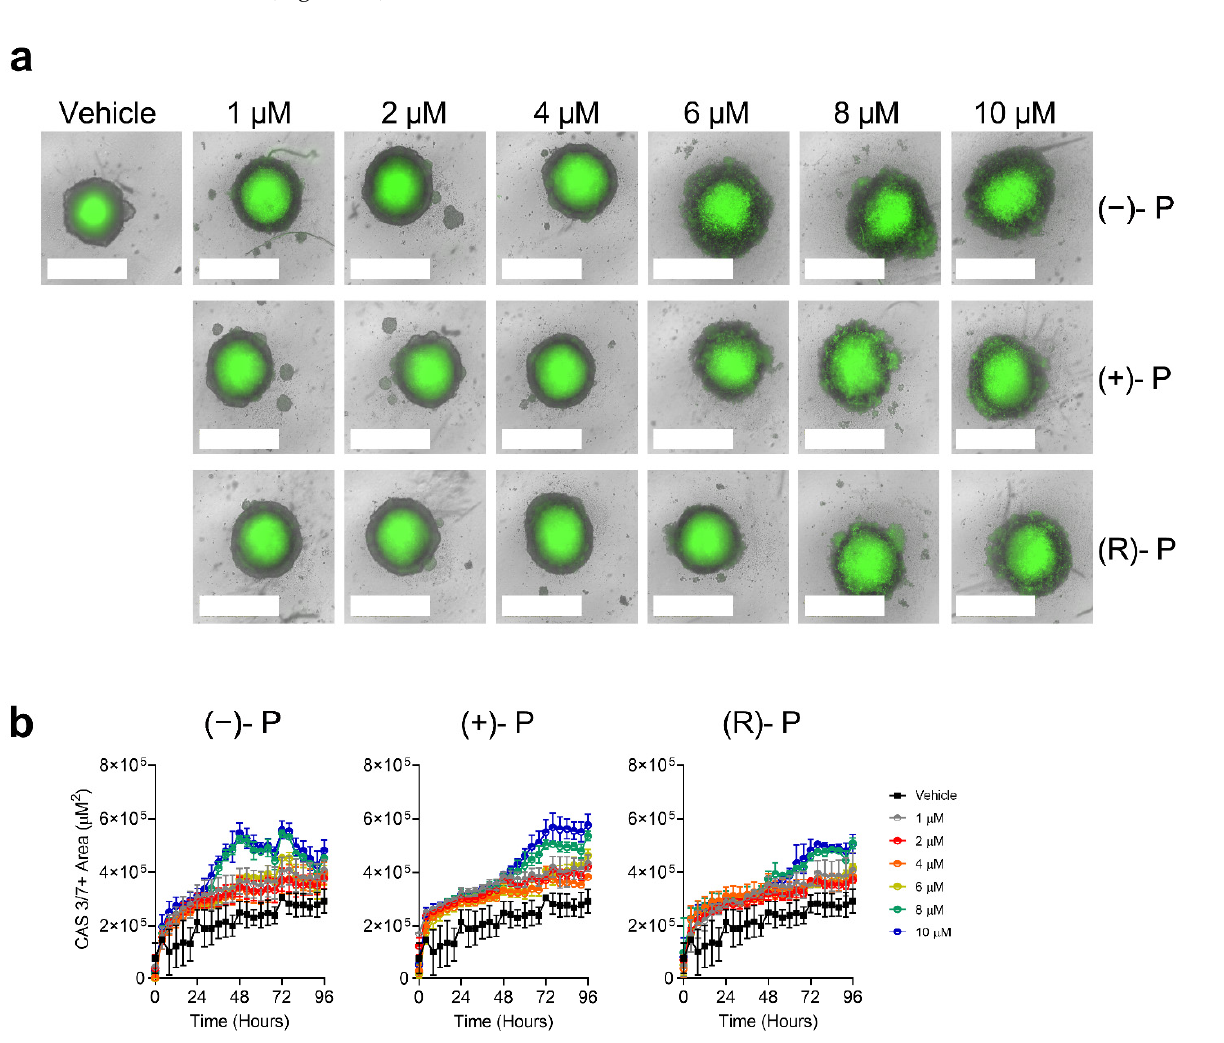
Figure 4. The kinetics of ( − )-P-, (+)-P- and (R)-P-induced caspase 3/7 activation in HT29 cells grown as spheroids. HT29 spheroids were grown for 96 h, followed by live-cell imaging for a further 96 h in the presence of ( − )-P, (+)-P and (R)-P and Caspase-3/7 Green reagent using an Incucyte S3 Live analysis system. ( a ) Representative images of HT29 spheroids 96 h post drug treatment. White bars represent 800 µm. ( b ) Caspase 3/7 kinetics curves generated by measuring the caspase 3/7 positive area within HT29 spheroids for ( − )-P, (+)-P and (R)-P over 96 h. ( c ) Comparison of caspase 3/7 acti- vation over 48 h after treatment with vehicle or 10 µM ( − )-P, (+)-P and (R)-P. Individual points rep- resent the mean ± SD from three technical replicates in a single experiment.*** p ≤ 0.001, **** p ≤ 0.0001. Two-way ANOVA with multiple comparisons test. Data are representative of two independ- ent experiments.